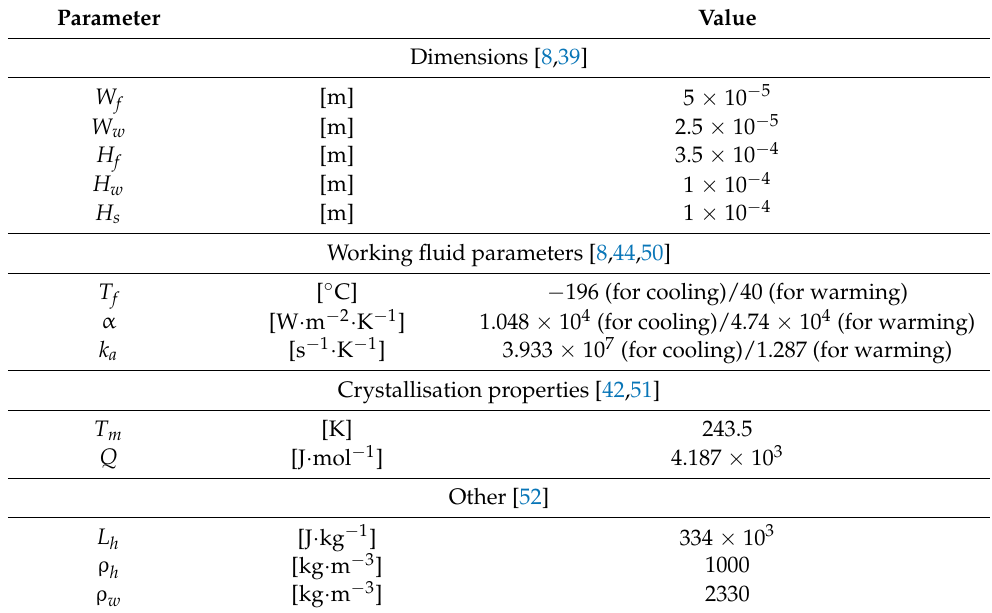
Table 1. Input data of the model.